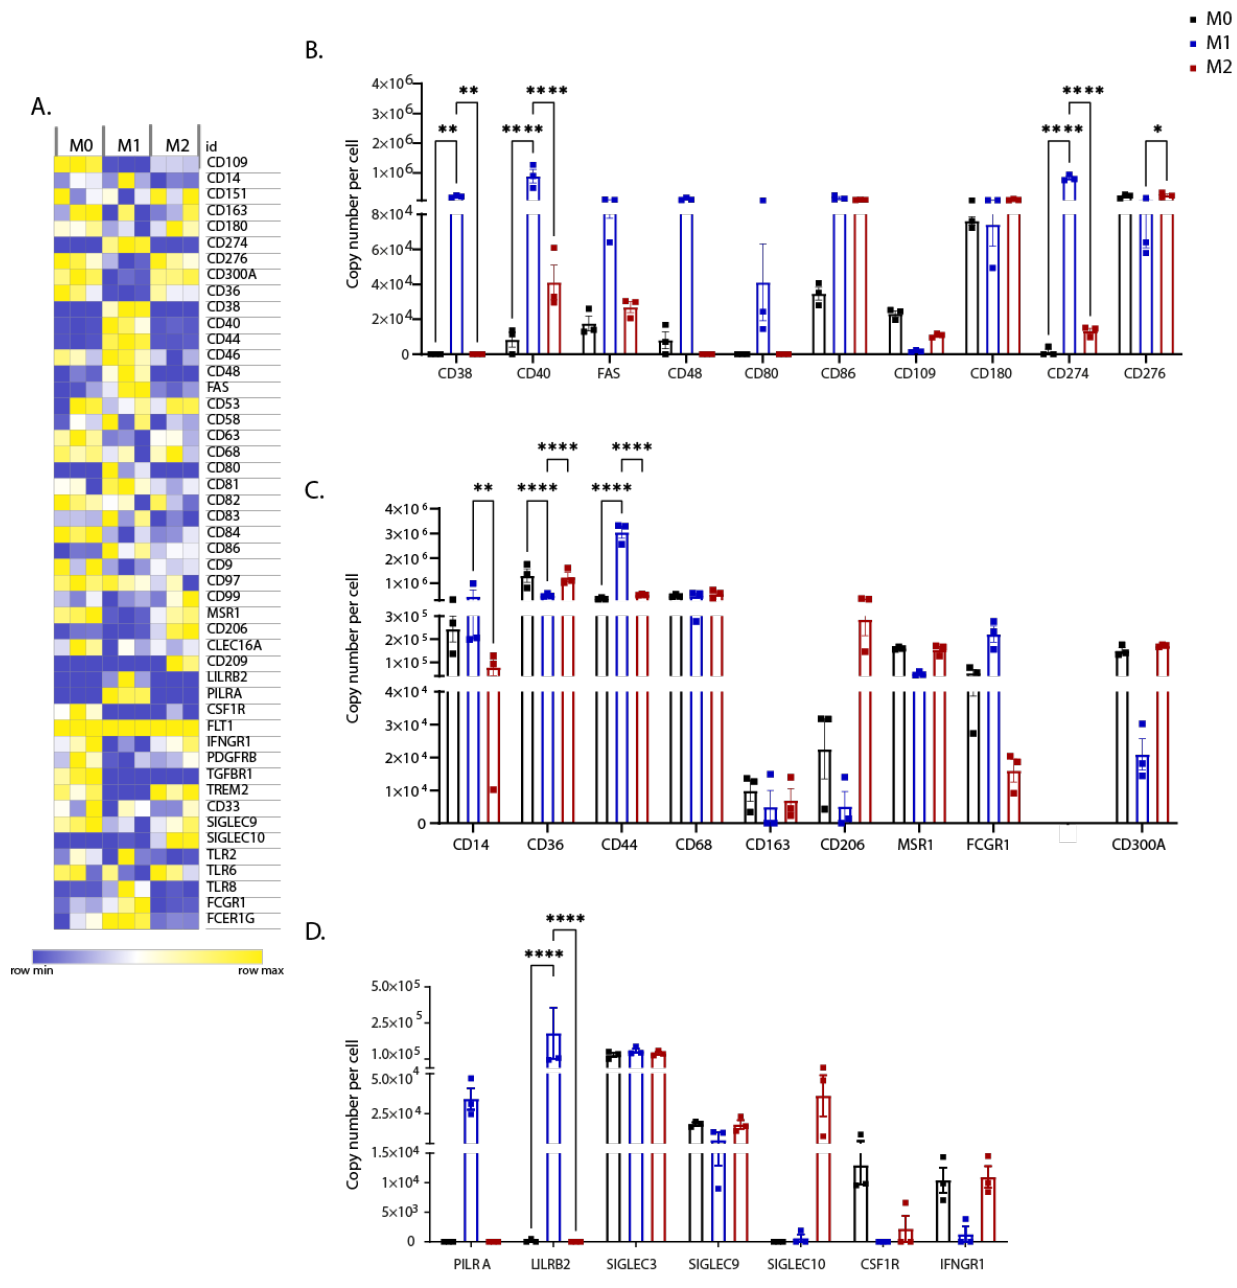
Figure 3. Expression levels of CD markers and other membrane proteins. ( A ) Heat map showing concentrations (in nM) of membrane proteins across biological replicates (n = 3) of differentially polarised iPSDM. ( B – D ) Graphs show the estimated copy numbers per cell using the proteomic ruler approach. p values: * 0.05, ** 0.01, *** 0.001, **** 0.0001.